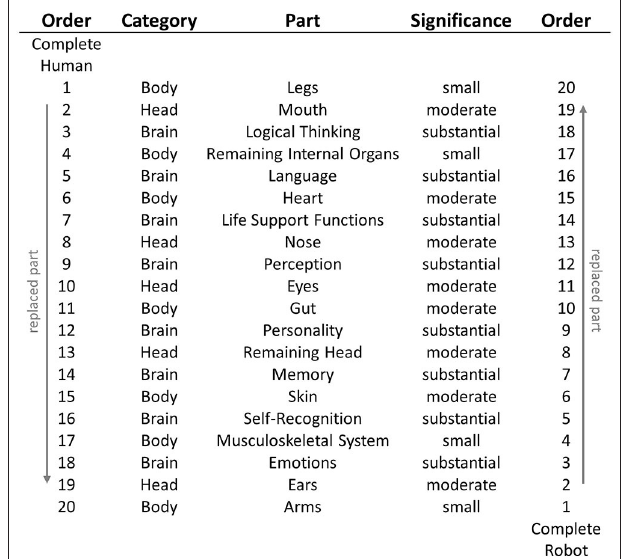
FIGURE 1 | Parts replaced in each step of the procedure, their category and significance for humanness/robotness and self and order number in the respective condition (left: starting with a complete human, right: starting with a complete